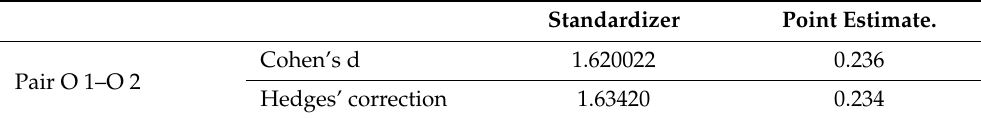
Table 4. Effect size analysis by Cohen’s d between Observation 1 (O 1) and Observation 2 (O 2). Standardizer Point